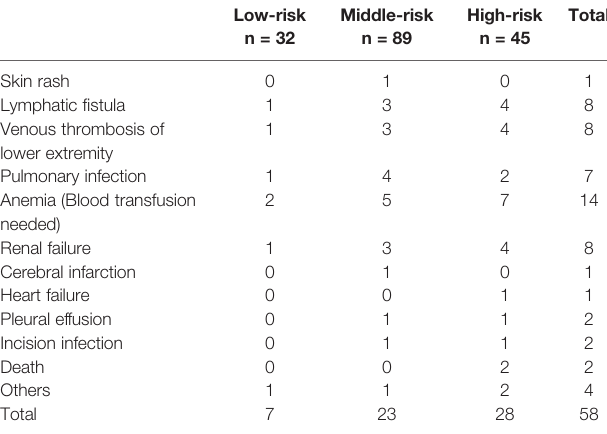
TABLE 4 | Postoperative complications in different T.H.R.O.B.V.S.